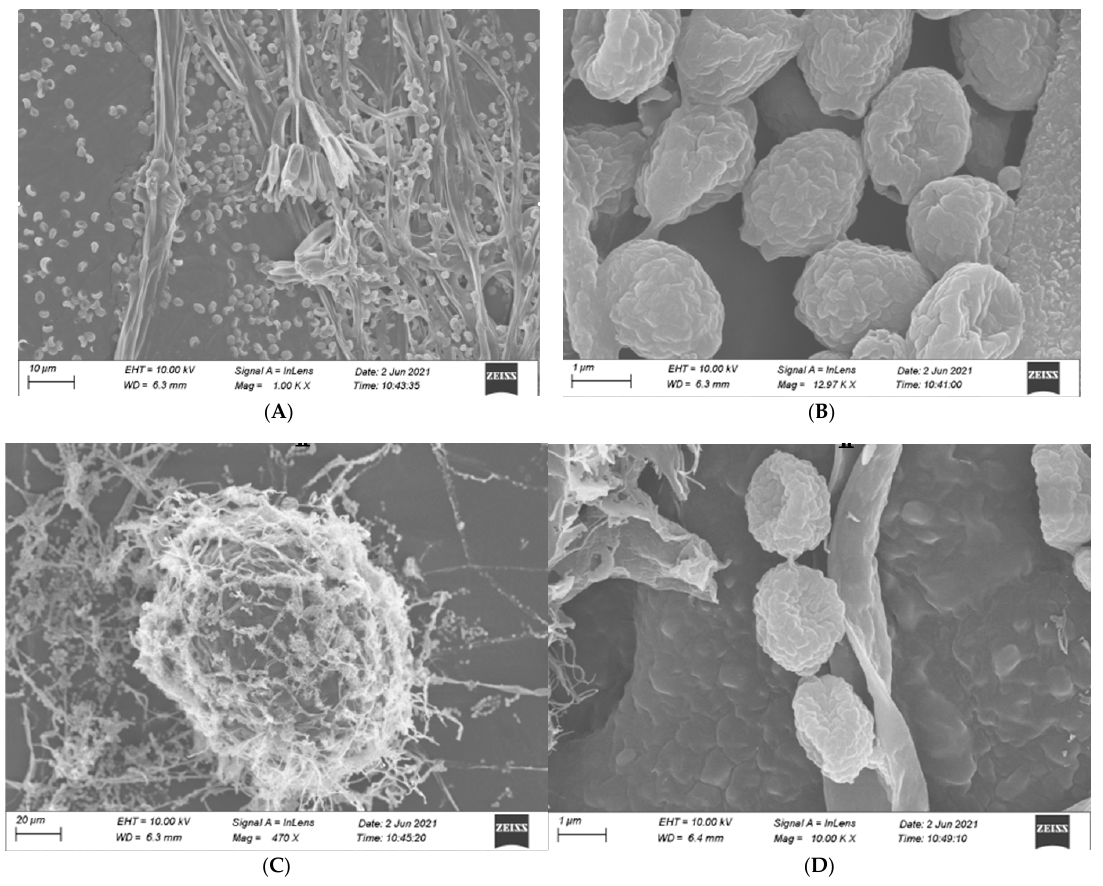
Figure 2. Morphology of reproductive structures of MR-16. A : Phialide, metulae and Stipe, B : Coni- dia, C : Ascomata, D : Ascospores. Scale bars: A = 10 µm; B = 1 µm; C = 20 µm; and D = 1 µm.